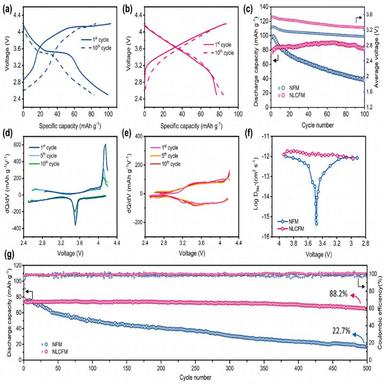
Electrochemical performance of NFM and NLCFM electrodes in half-cell system. (a–b) Galvanostatic charge/discharge curves at 0.1C of NFM and NLCFM electrodes, respectively. (c) Comparisons of average voltage and cycling performance at 0.1C. (d–e) dQ/dV curves of NFM and NLCFM electrodes. (f) Na+ chemical diffusion coefficient calculated from GITT data for NFM and NLCFM electrodes. (g) Cycling performance of NFM and NLCFM at 2C over 500 cycles.